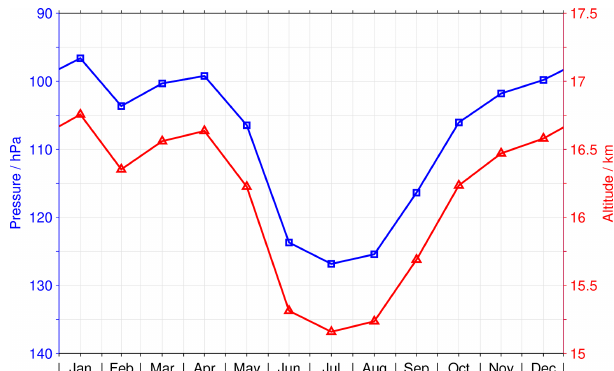
Figure 7. The annual variation of the start altitude for the HDO retrieval, i.e. the lowest altitude where sensible data can be derived from the MIPAS observations, considering data in the latitude range between 15 ◦ S and 15 ◦ N. The blue line shows the variation in pres- sure (uses the left axis), and the red line considers the geometric altitude (uses the right axis).